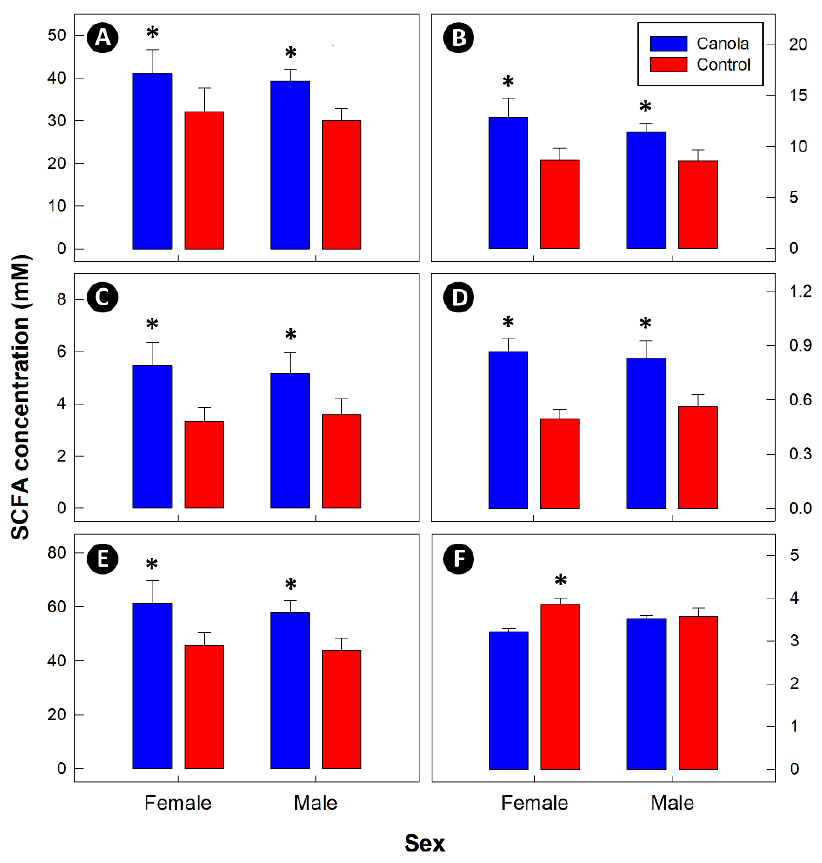
Figure 5. Short-chain fatty acid (SCFA) concentrations in the cecal digesta of 35-day-old broilers fed a diet supplemented with canola meal (20%) relative to a control diet as measured by gas chromatography. ( A ) Acetate. ( B ) Proprionate. ( C ) Butyrate. ( D ) Valerate. ( E ) Total SCFAs. ( F ) Ratio of two carbon to three carbon SCFAs. There was no difference ( p ≥ 0.549) between females and males, and in both sexes higher ( p ≤ 0.025) concentrations of SCFAs were observed in the cecal digesta of birds fed the diet with canola meal (indicated by asterisks).